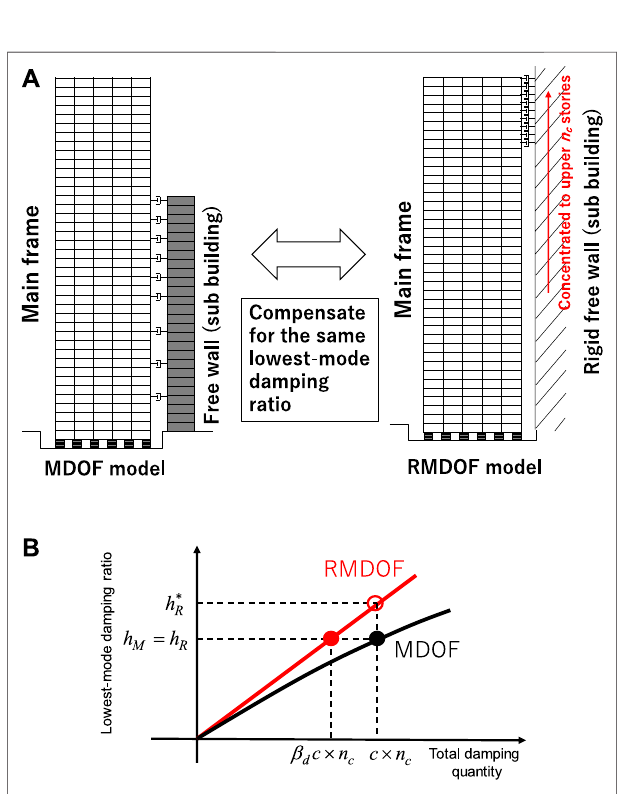
FIGURE 8 | Introduction of RMDOF model and procedure for evaluating compensation factor β d , (A) MDOF plane frame model with hybrid control system and RMDOF plane frame model, (B) Procedure for evaluating compensation factor β d without